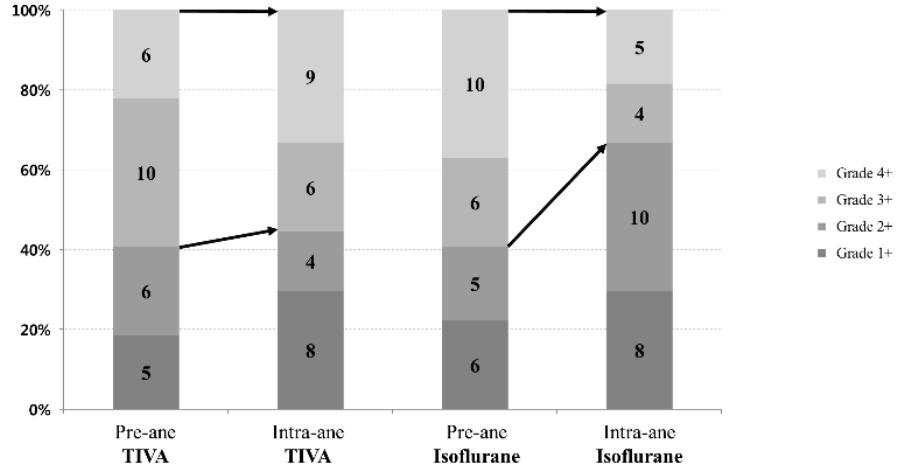
Figure 2. Changes in intraoperative and preoperative mitral regurgitation grade. In the TIVA group, there was no change in mitral regurgitation grade 3 and 4; however, in the isoflurane group, mitral regurgitation grade 3 and 4 decreased during anesthesia.